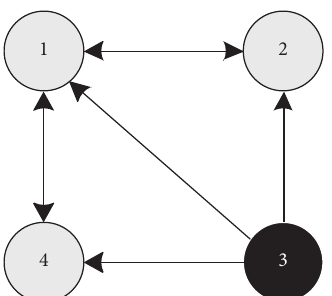
Figure 4: Leader-follower communication topology among